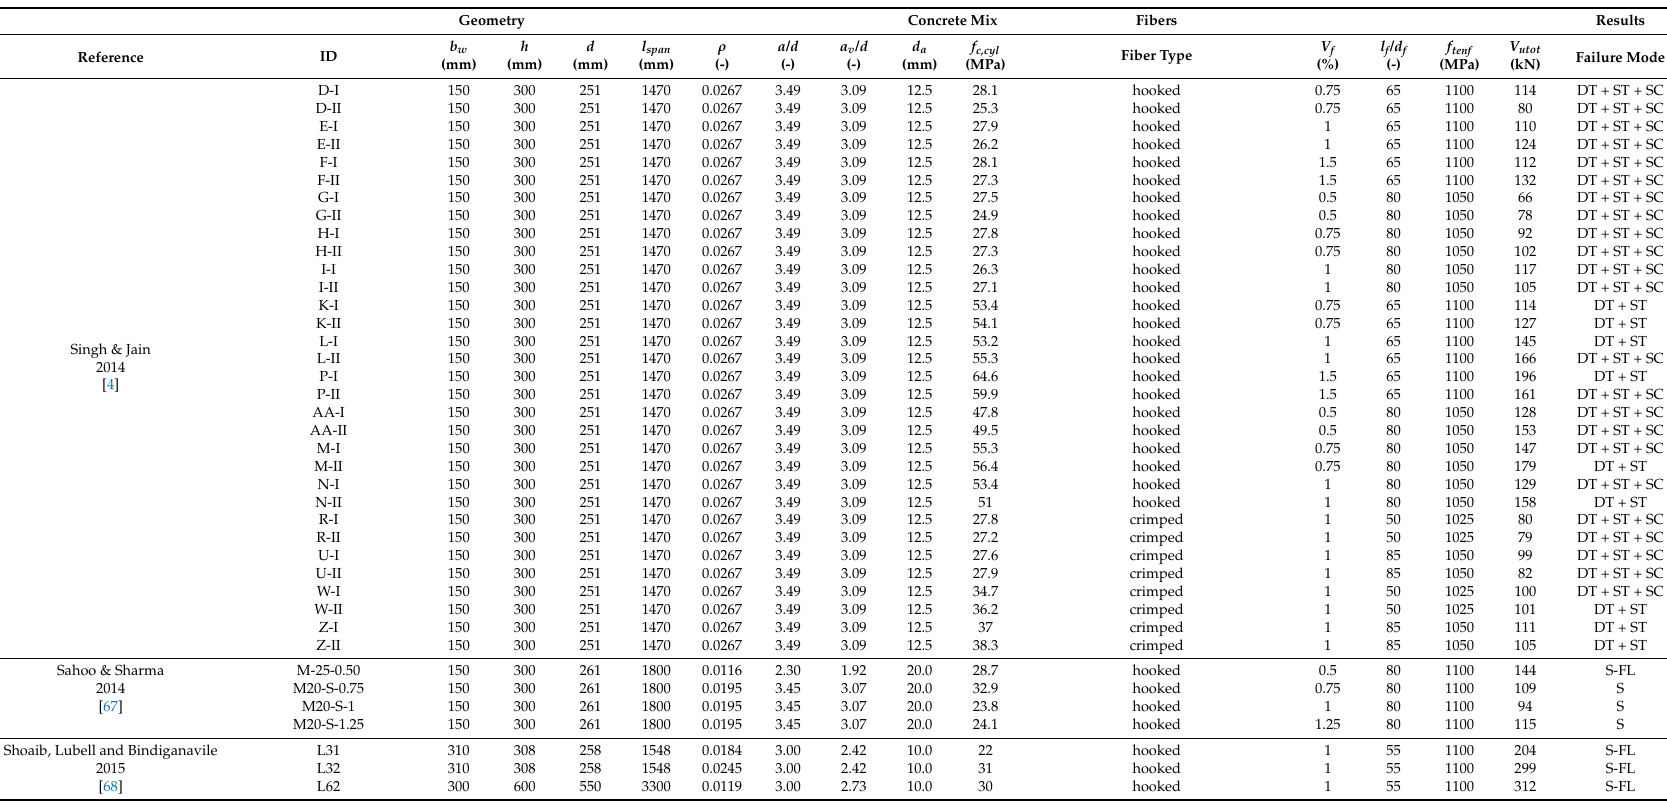
Table A1. Database of experimental results from literature of SFRC beams with longitudinal reinforcement without stirrups failing in shear.